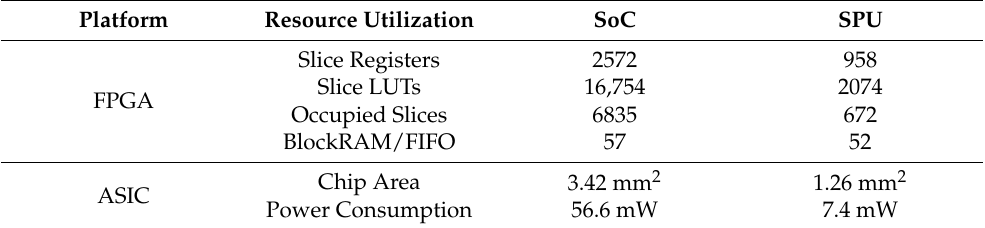
Table 6. The CPU–SPU collaborative SoC hardware implementation on FPGA and